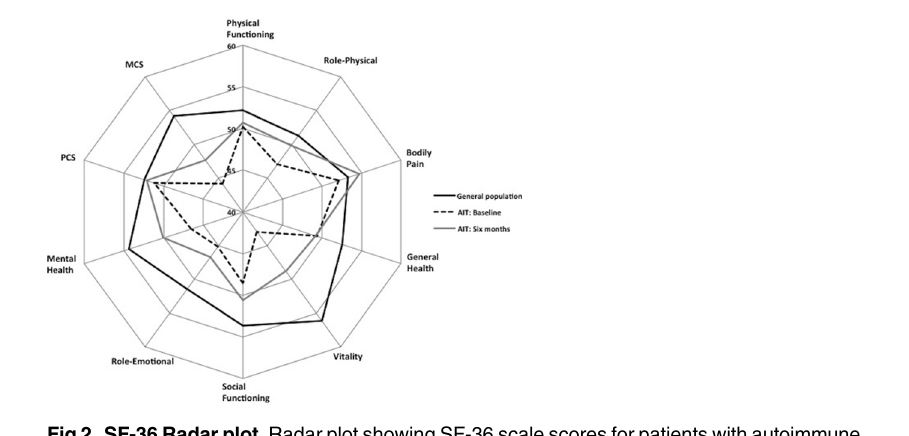
Fig 2. SF-36 Radar plot. Radar plot showing SF-36 scale scores for patients with autoimmune hypothyroidism (AIT) at baseline and 6-months follow-up as well as scores from the general reference population. Higher scores indicate better health